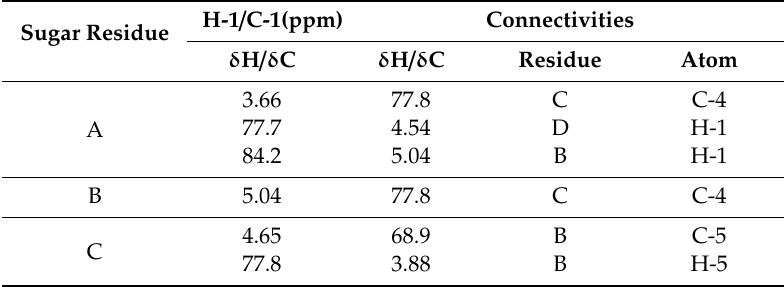
Table 6. The significant connectivities observed for the anomeric protons / carbons of PCp-1 in HMBC spectrum.